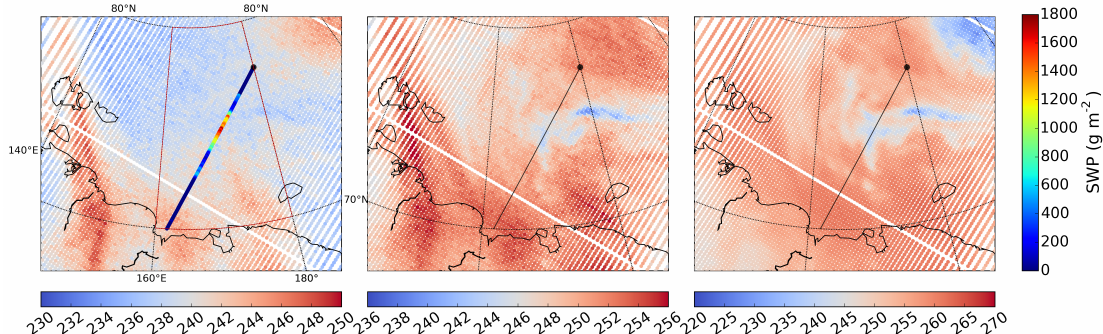
Figure 5. BT (K) measured by MHS for 183.3 ± 1 GHz, 183.3 ± 3 GHz, and 190.3 GHz (from left to right). The black line indicates the CloudSat overpass seen in Figure 4, while the black dot shows the beginning of the track. In the left panel, the CloudSat track shows snow water path (SWP) (g m − 2